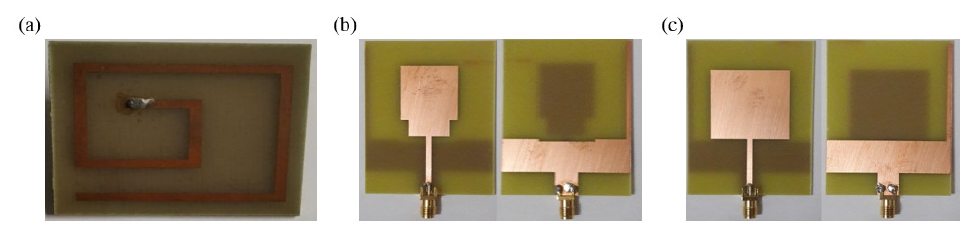
Figure 9. Three microstrip antennas compared in terms of their sensor performance for glucose detection. ( a ) Spiral antenna. ( b ) UWB patch antenna. ( c ) Narrowband patch antenna (Reprinted with permission from [84]; © 2021